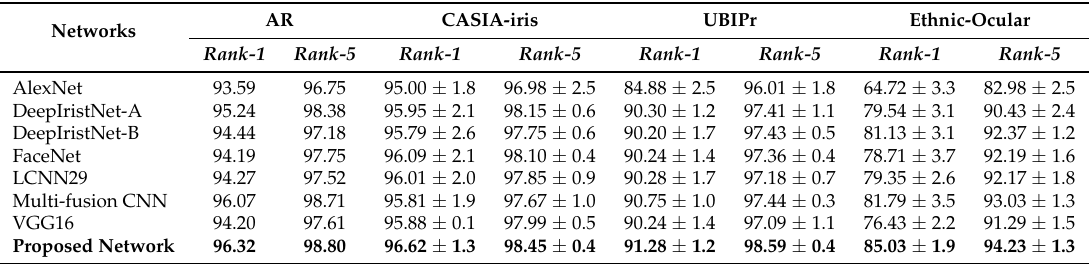
Table 3. Performance evaluation of the recognition task on the AR database, CASIA-iris distance database, UBIPr database, and Ethnic-ocular database. The highest accuracy is written in